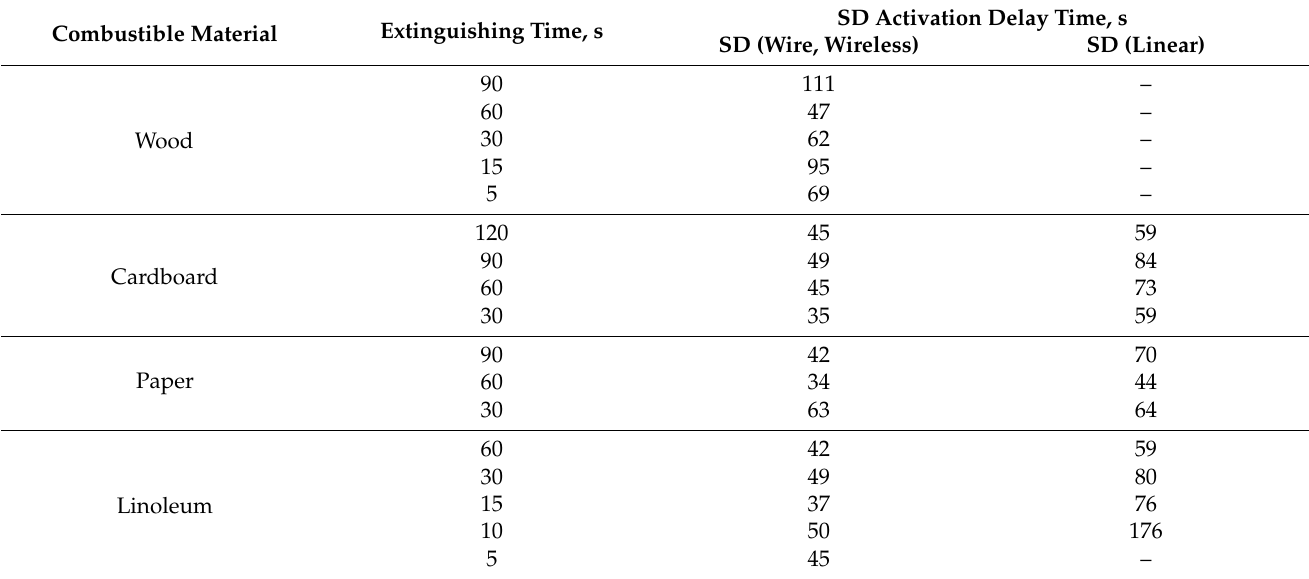
Table 4. SD activation delay times when varying the hot plate surface temperature under imitated conditions of unsafe operation of heating equipment with extinguishing the